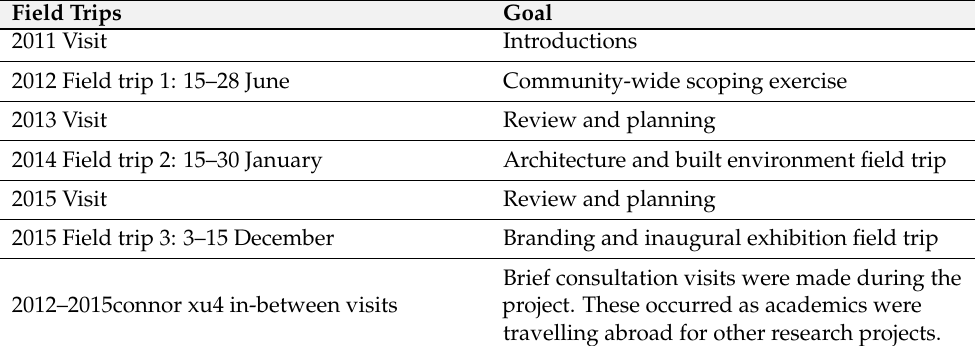
Table 1. Field trips to the Kelabit Highlands over five